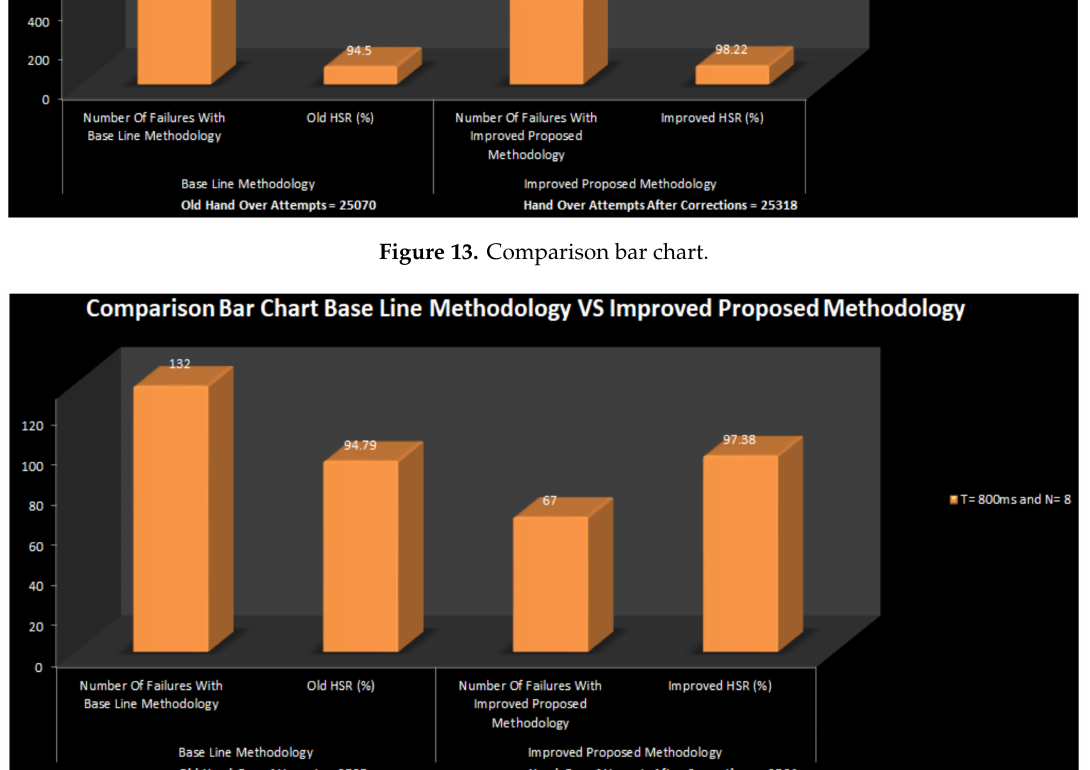
Figure 14. Comparison bar